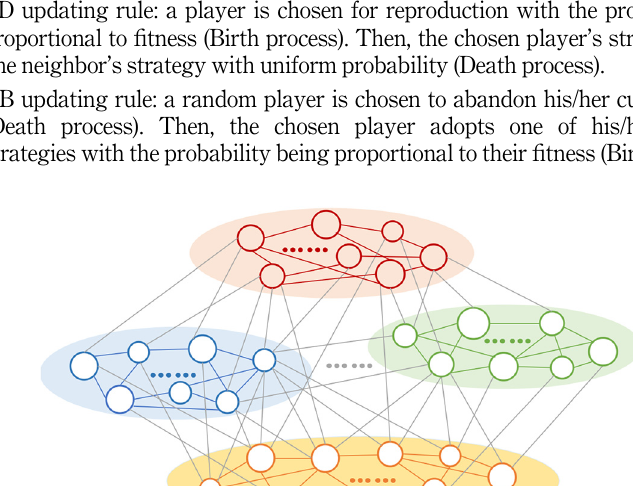
Figure 1. An illustration of the social